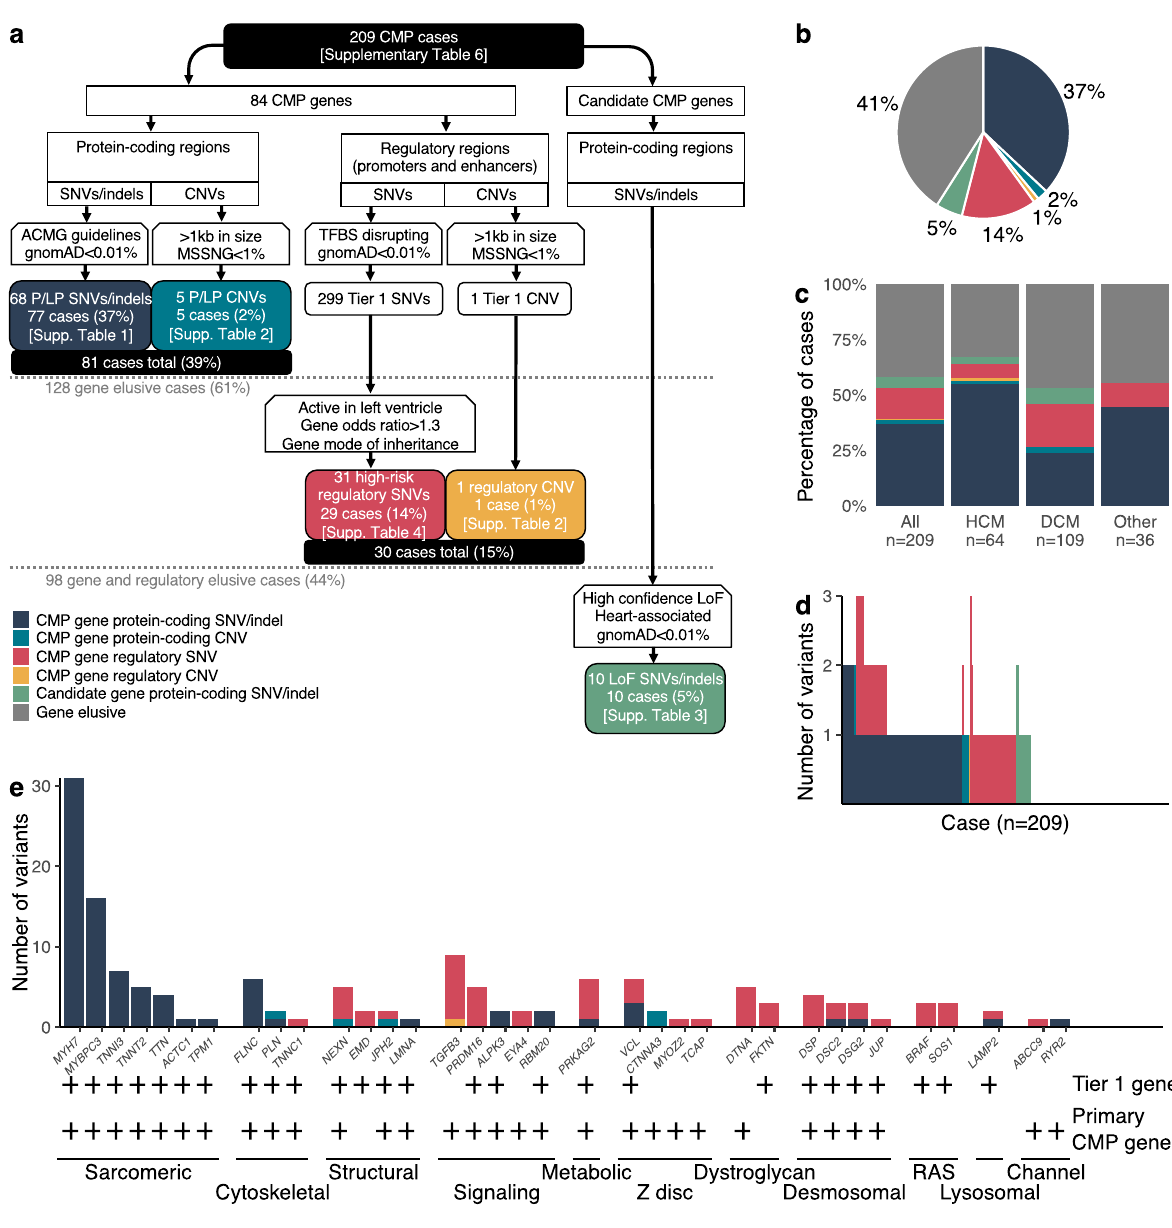
Fig. 1 Yield of protein-coding and regulatory variants in 209 unrelated childhood CMP cases. a Flow-chart showing the selection process and yield of protein-coding and regulatory variants in the overall cohort and in the gene-elusive subset. Totally, 39% of all cases harbored at least one pathogenic protein-coding variant in a CMP gene; among the remaining 128 gene elusive cases, 15% harbored at least one prioritized high-risk regulatory variant in a CMP gene; and an additional 5% harbored an LoF variant in a new candidate CMP gene. b Pie diagram showing the distribution of protein-coding and regulatory variants in CMP genes and LoF variants in new CMP genes across the cohort ( n = 209). WGS identi fi ed putatively pathogenic protein-coding SNVs/indels/CNVs in CMP genes in 39% of cases, high-risk variants in regulatory elements of CMP genes in an additional 15% of cases, and loss of function (LoF) variants in candidate genes in an additional 5% of cases. c Variant distribution by CMP subtypes: HCM cases had a higher yield of pathogenic protein-coding variants compared to other CMP subtypes (odds ratio 2.8, CI: 1.5 – 5.2, p = 7.07 × 10 − 4 ). d Variant burden by the patient: 9 cases (4.3%) had multiple protein-coding variants in known CMP genes, 2 cases (1.0%) had multiple prioritized regulatory variants, and 21 cases (10.0%) had both protein-coding and regulatory variants in CMP genes. Regulatory variants in all cases were further prioritized if they were active in human LV, were rare in control subpopulations (Popmax AF < 0.1%), and were associated with genes enriched in cases versus controls with OR ≥ 1.3. e Variant distribution by functional gene categories: of all the pathogenic protein-coding variants, 66% was in sarcomere genes which represented a signi fi cant enrichment compared to other gene categories (binomial p = 3.99 × 10 − 29 ). Conversely, none of the high-risk regulatory variants were in sarcomere genes. Tier 1 gene and primary CMP gene classi fi cations are denoted by plus symbols. CMP cardiomyopathy, SNV single nucleotide variant, CNV copy number variant, gnomAD Genome Aggregation Database, ACMG American College of Medical Genetics; Association for Molecular Pathology (AMP), TFBS transcription factor binding site, P/LP pathogenic or likely pathogenic, LoF loss of function, HCM hypertrophic cardiomyopathy, DCM dilated